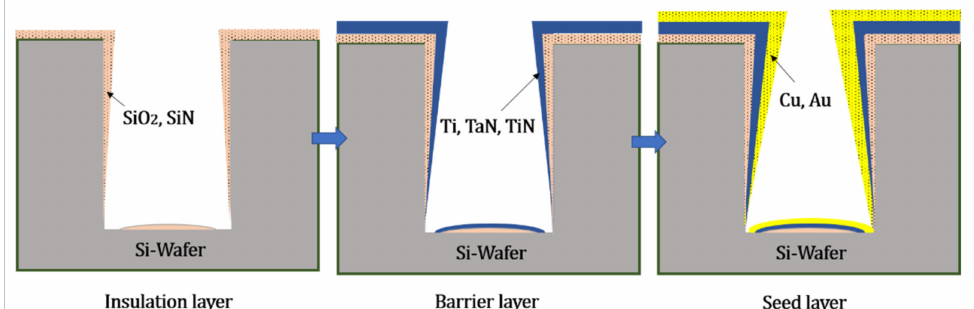
Figure 7. Schematic illustration of functional layers on